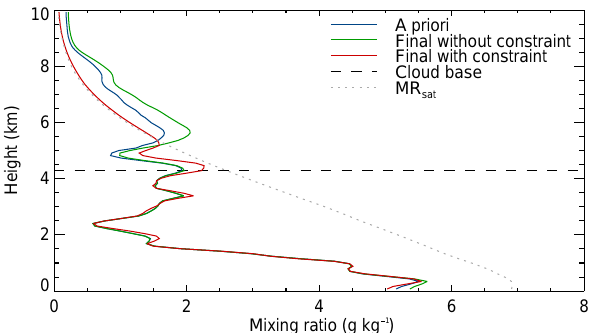
Figure 6. Illustration of the optimal estimation method. Details are given in the